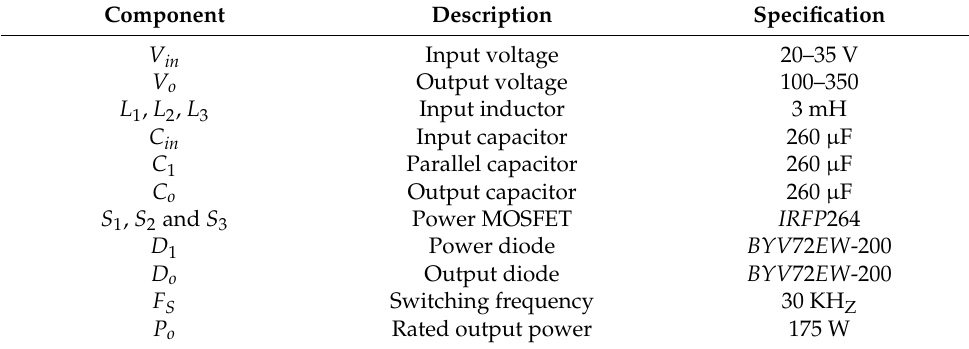
Table 3. The specification of the system